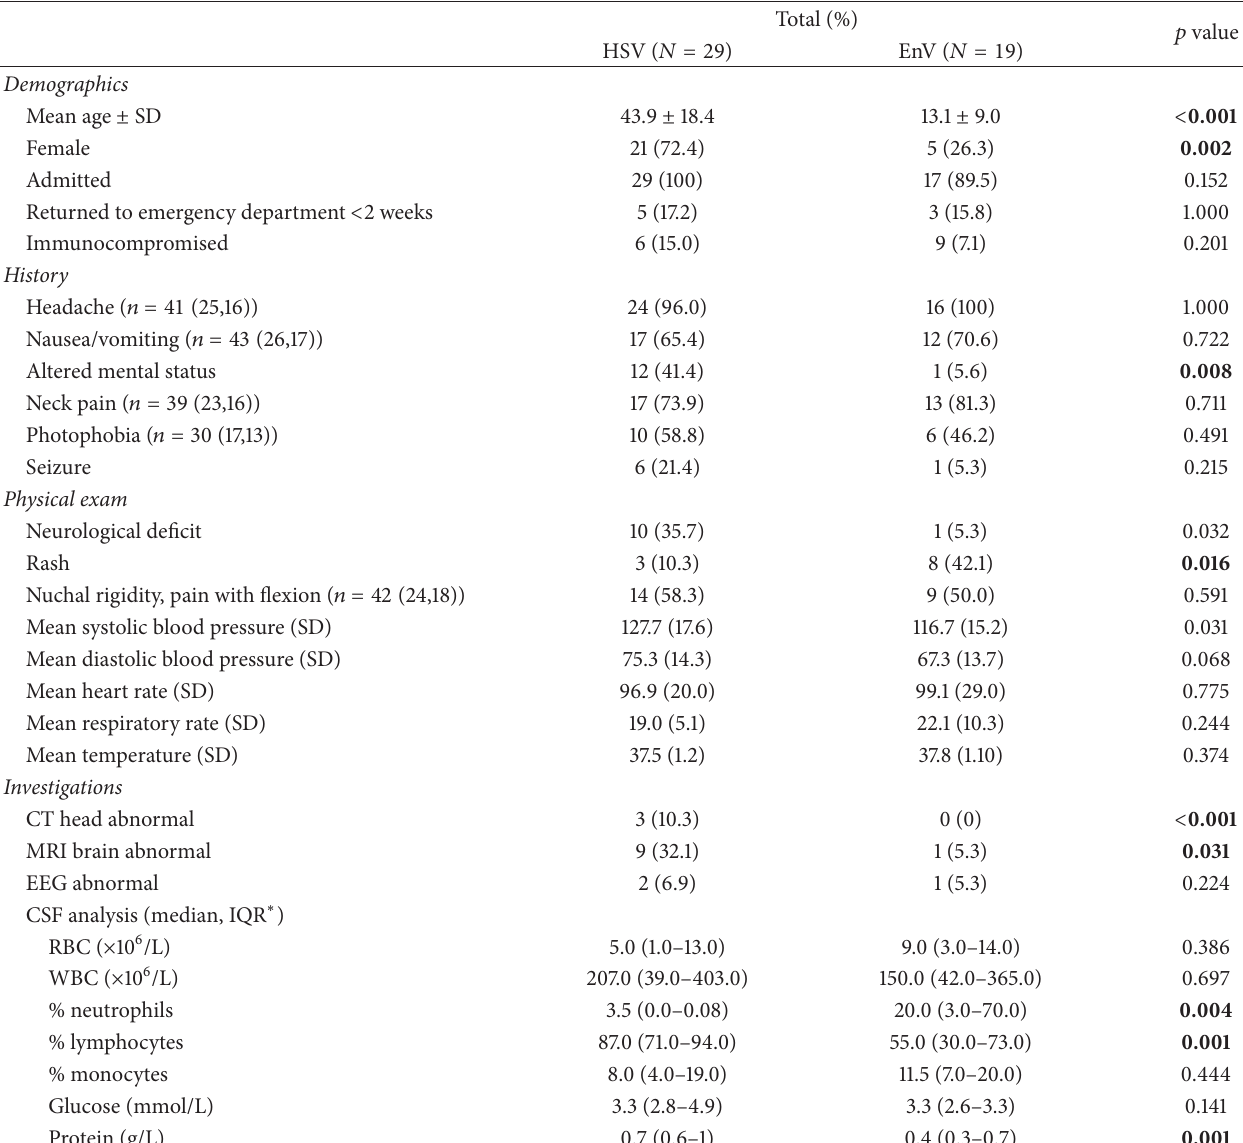
Table 3: Subgroup analysis comparing demographic and clinical characteristics and investigations between patients with confirmed HSV and confirmed EnV ( 𝑁 = 48